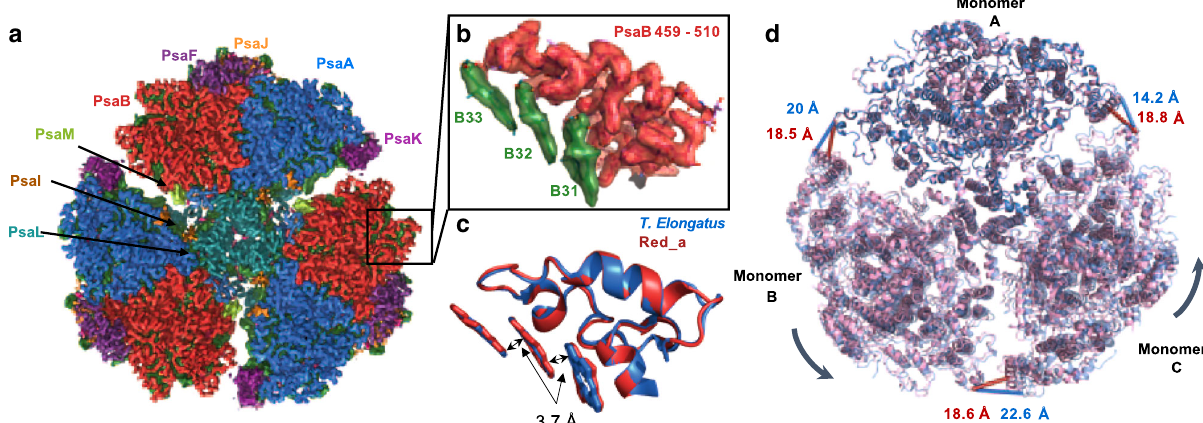
Fig. 6 Cryo-EM structure of the Red_a PSI complex. a A view from the lumen side of the membrane of the Red_a PSI trimer map, protein subunits are colored individually, all Chls in green, Cars in pink, and lipids in orange. b The map and model of Red_a in the B31-B32-B33 region as viewed from the membrane plane. c Superposition of the Red_a structure (in red) and the same region from T. elongatus (PDBID: 1JBO, in blue). d Superimposing the WT trimer structure (PDBID: 5OY0, in blue, semitransparent in monomers ‘ B ’ and ‘ C ’ ) over the Red_a trimer (PDBID: 6UZV, in pink). Monomers ‘ A ’ were superimposed using all their protein backbone atoms. A clear shift of ~4 Å is seen for monomers ‘ B ’ and ‘ C ’ . Distances separating individual PSI monomers are shown in blue for the crystallographic, wild type, model, and in red for the, Red_a, Cryo-EM model, showing very similar monomer spacing in the Cryo-